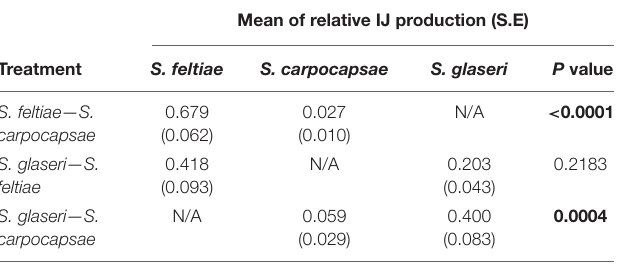
TABLE 1 | Proportional IJ production (IJ p ) in various heterospecific pairings.